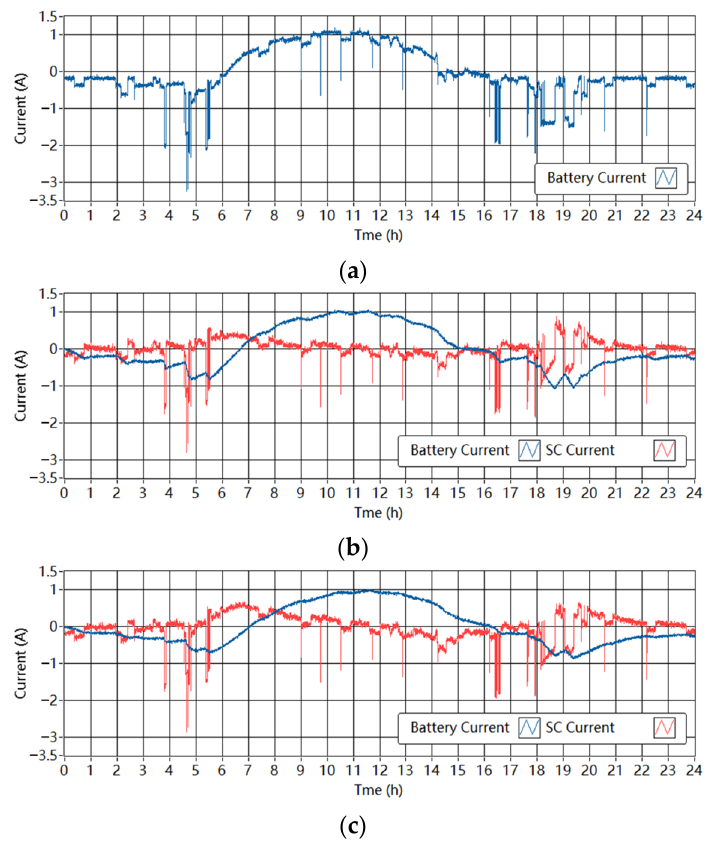
Figure 13. Measured currents through the ESDs in the experimental setup in the PV-powered system. ( a ) Single-battery ESS. ( b ) Battery-SC HESS when T f is 1800 s. ( c ) Battery-SC HESS when T f is 3600 s.